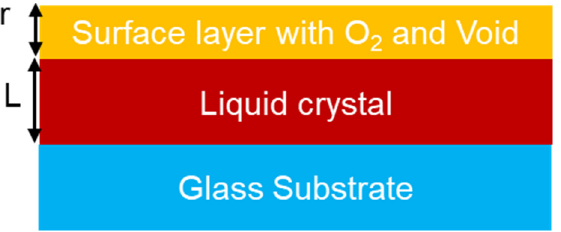
Figure 8. The optical model used to extract the optical constants of liquid crystalline thin films.